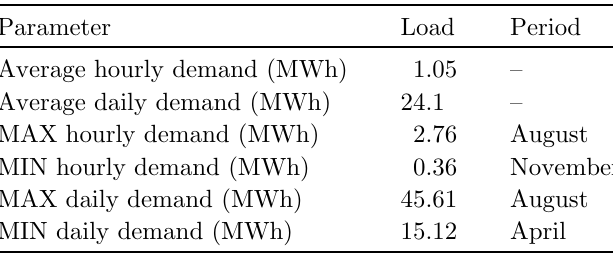
Table 1. Seasonal load demand